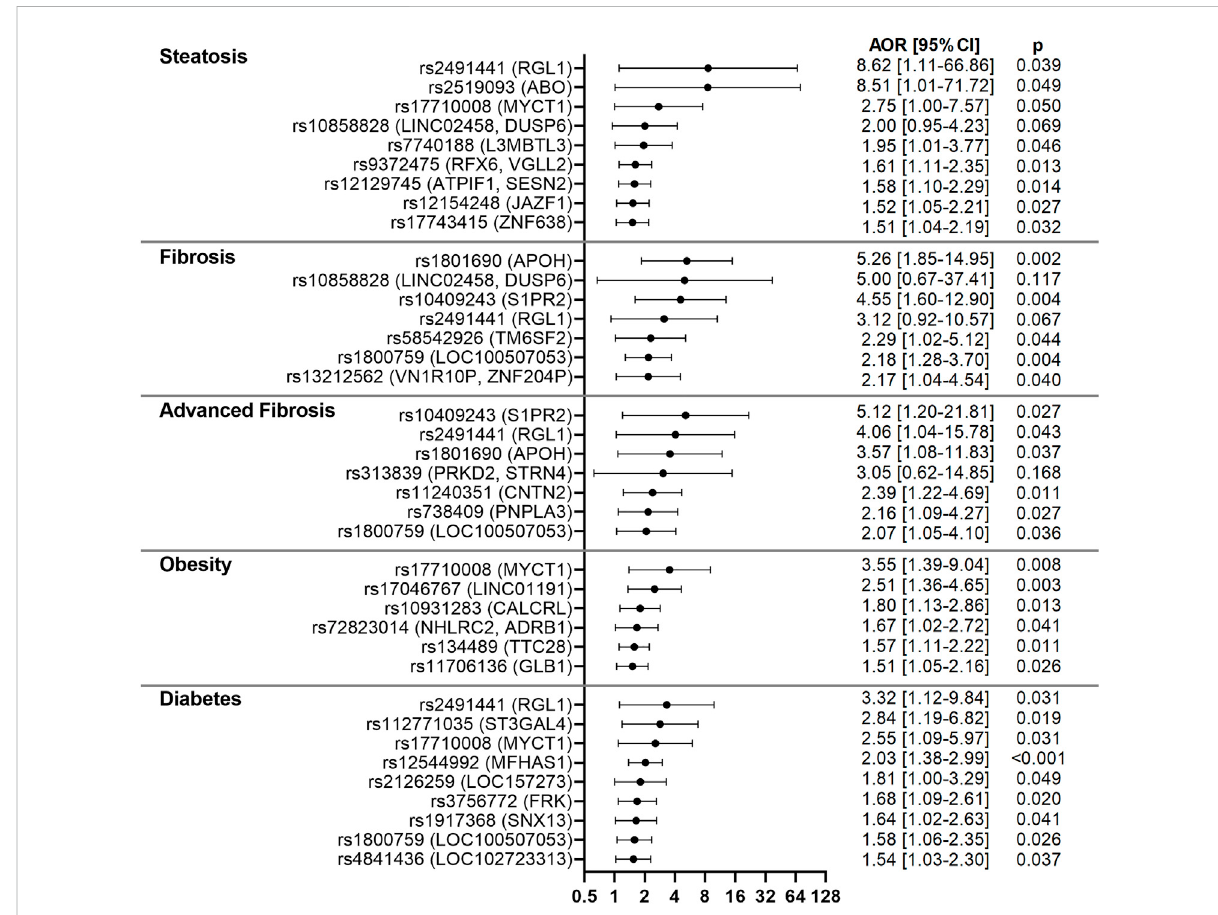
FIGURE 4 Forest plots for variants associated with NAFLD-related clinical parameters in the CCHC. Forest plots show AORs [95% CI] for steatosis, liver fi brosis, advanced fi brosis, obesity and diabetes, after adjusting for age and gender. The top variants associated with each outcome are